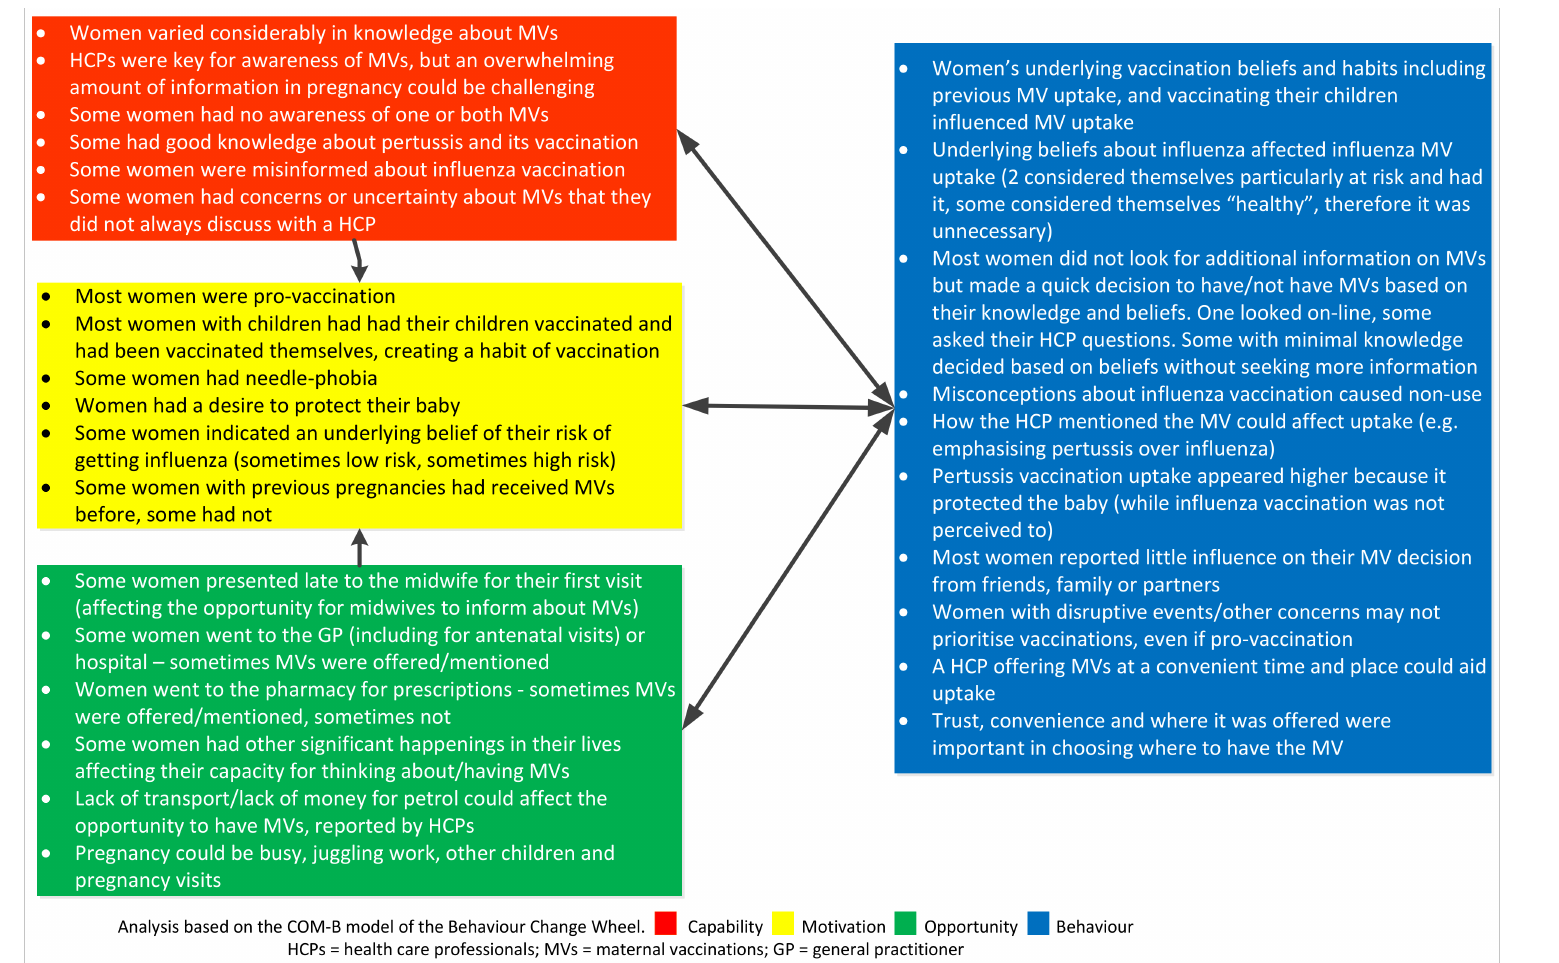
Figure 1. Factors influencing the uptake of maternal vaccines (MVs) for women using the COM-B